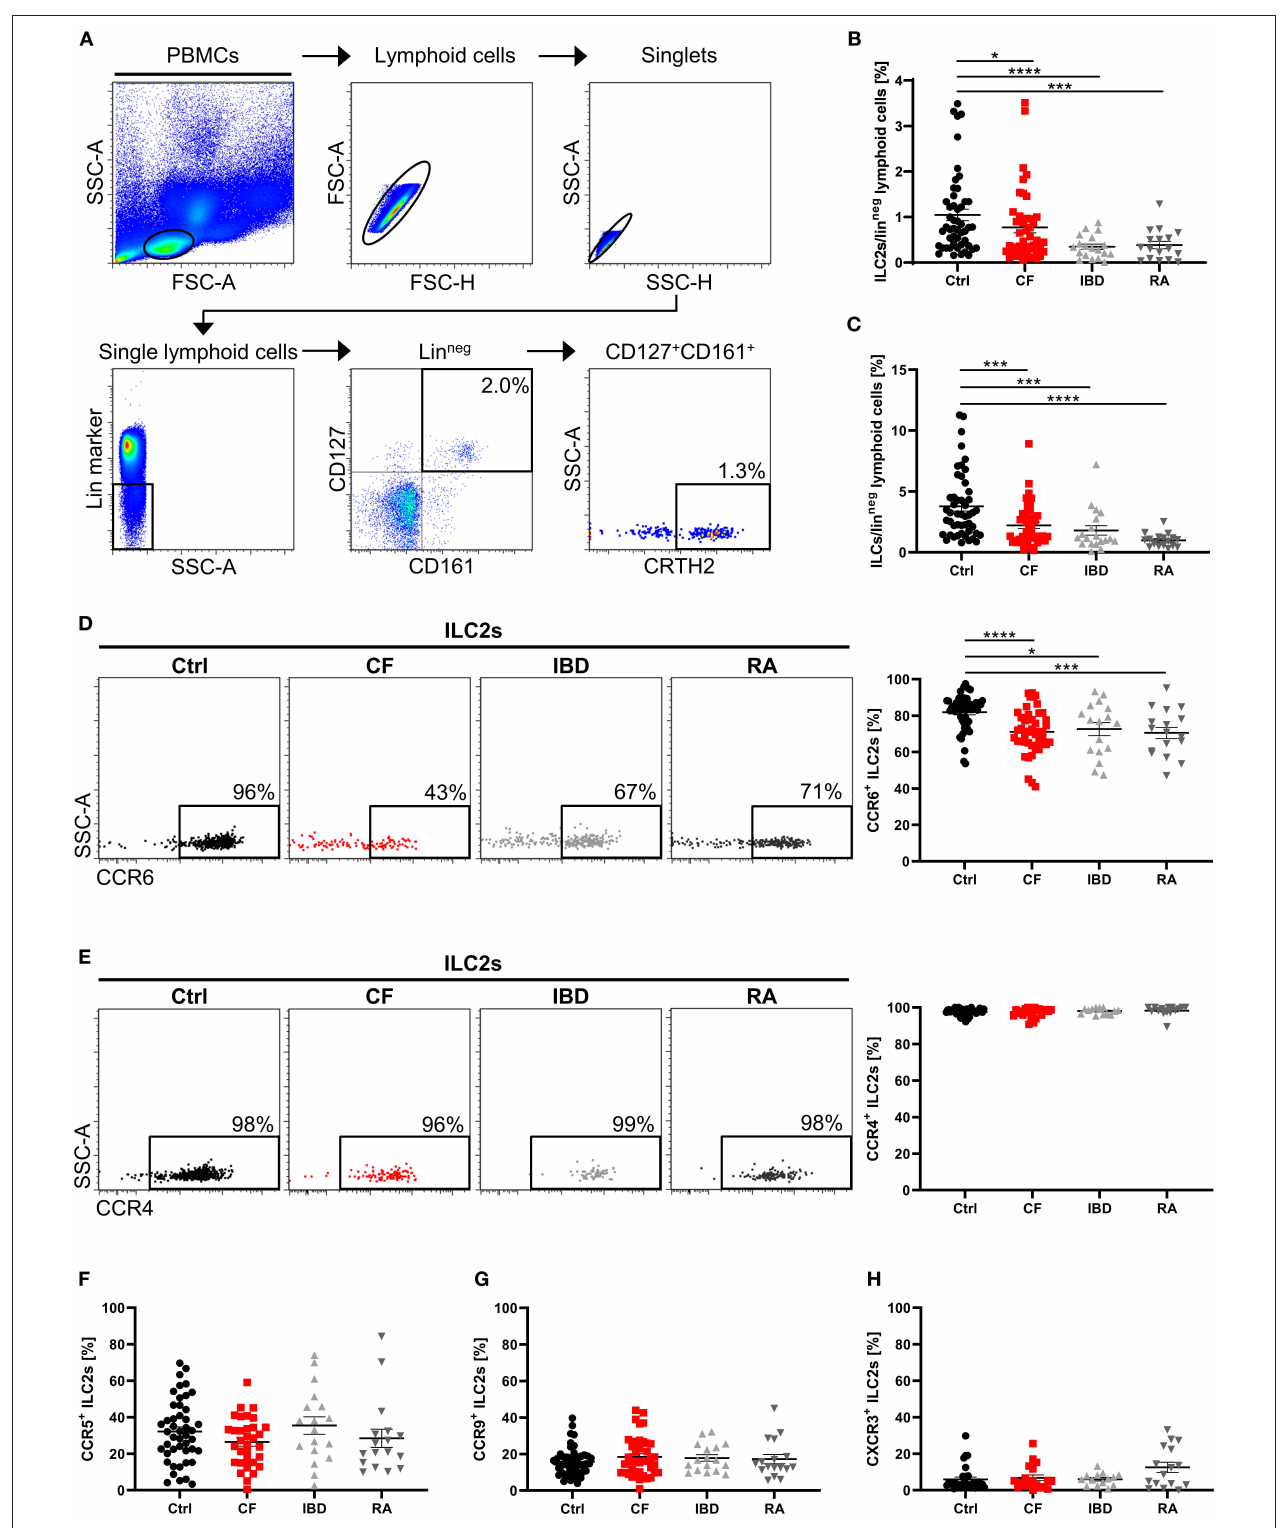
FIGURE 1 | Altered ILC2 profile in the peripheral blood of patients with chronic inflammatory diseases. (A) Representative gating scheme for the flow cytometric identification of human pb ILC2s as Lin neg CD127 + CD161 + CRTH2 + lymphoid cells in total PBMCs. Percent values indicate frequencies of gated cell populations on